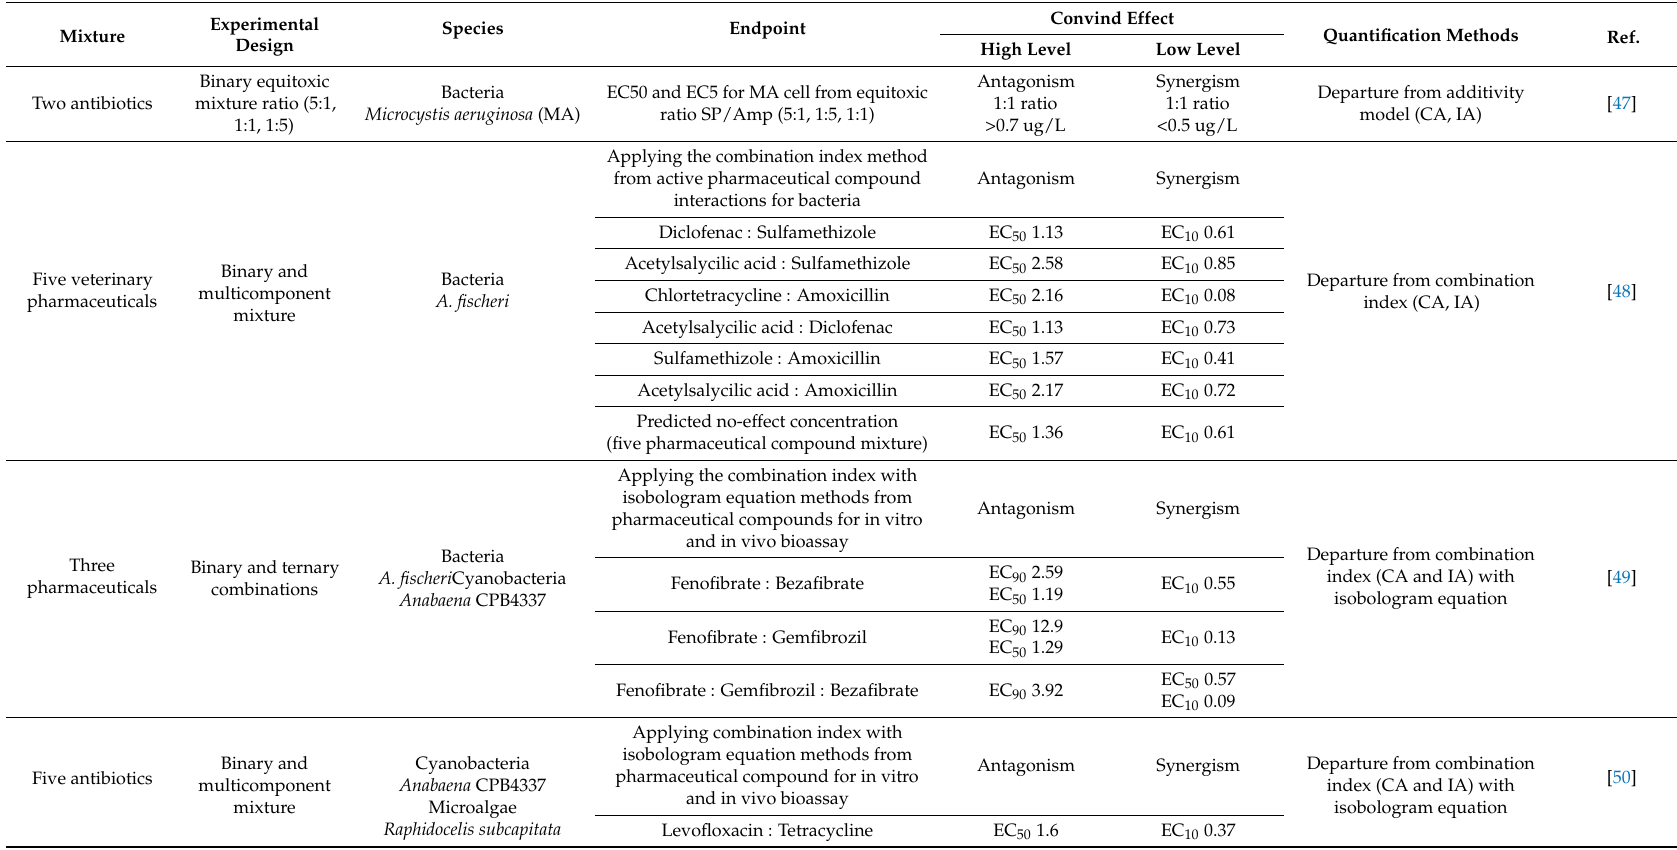
Table 5. A summary of the studies related to the interaction of inversion